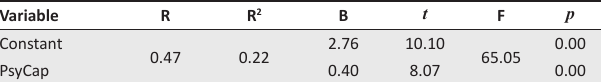
PsyCap, psychological capital; OCB, organisational citizenship behaviour. Dependent variable: OCB. Predictors (constant):